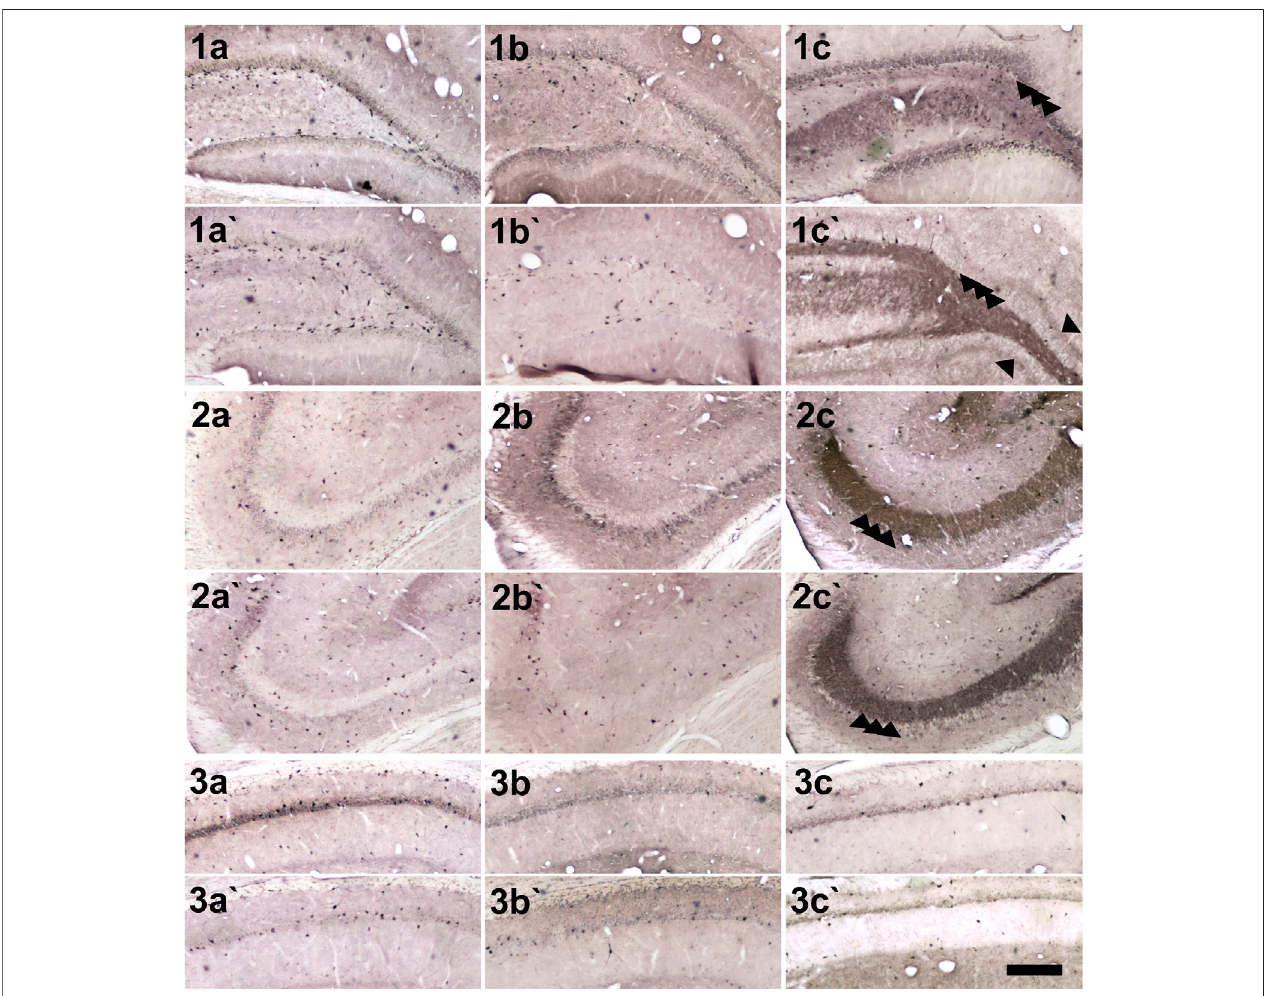
FIGURE5| PhotomicrographsofNPY+cellsinhippocampalregions.(1)Dentategyrusandhilus,(2)CA3and(3)CA1.(a,bandc)Anx(a`,b`andc`)Non-Anx(a,a`) Controls (b, b`) NoSE (c, c`) SE. Note intense (darker) and widespread staining in regions which coincide with mossy fi ber sprouting in the dentate gyrus, hilus and CA3, exclusively in SE animals (arrow heads). Scale bar: 250 μ